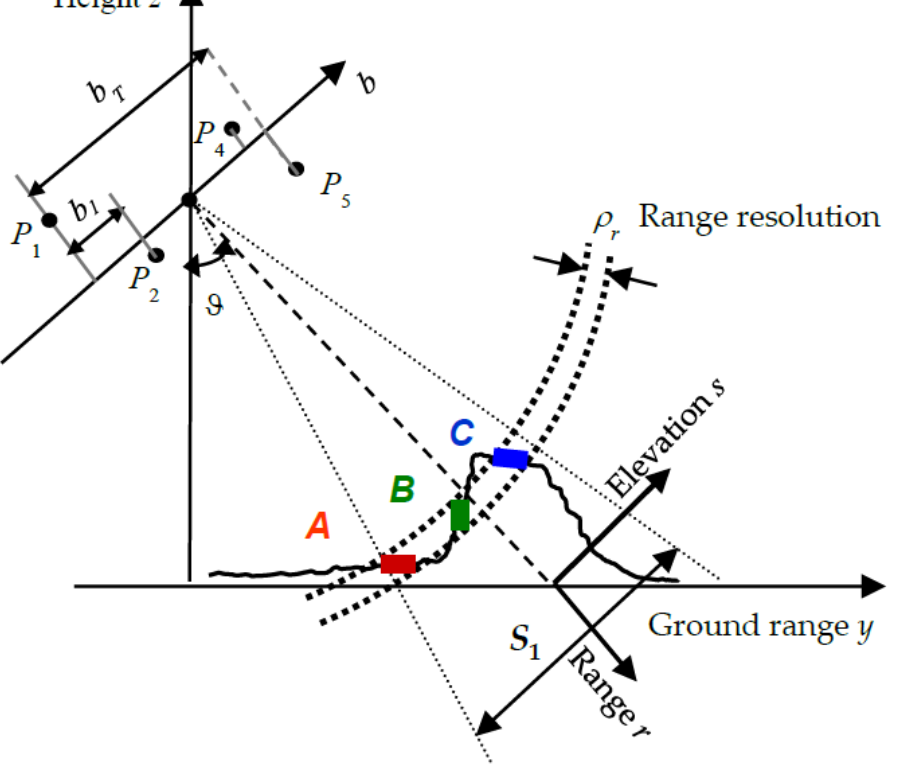
Figure 1. Range–elevation geometry, fixing the x Figure 1. Range – elevation geometry, fixing the x coordinate.